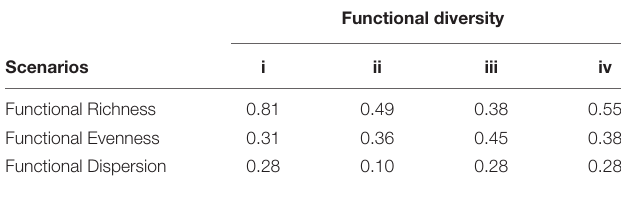
highest scores on axis 1 of the NMDS. The relative abundance of species with autotrophy and myxotrophy was functionally more equitative in the scenarios under the influence of